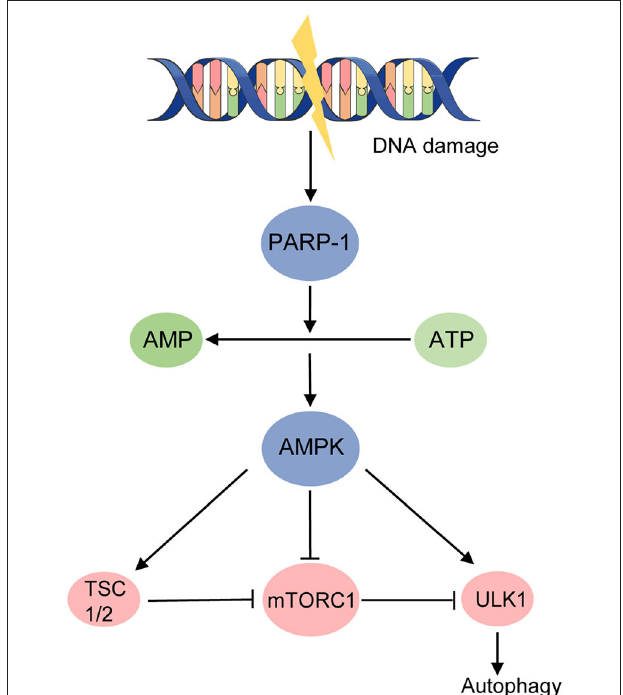
FIGURE 2 | DNA damage activates autophagy in an energy starvation environment. AMPK activates autophagy in three mechanisms during energy starvation: (1) binding to and activating ULK1 through direct phosphorylation; (2) inhibiting mTORC1 directly; (3) activating TSC2 to suppress mTORC1. Hyperactivated PARP-1 induced by DNA damage raises the ratio of AMP to ATP and activates AMPK, ultimately promoting